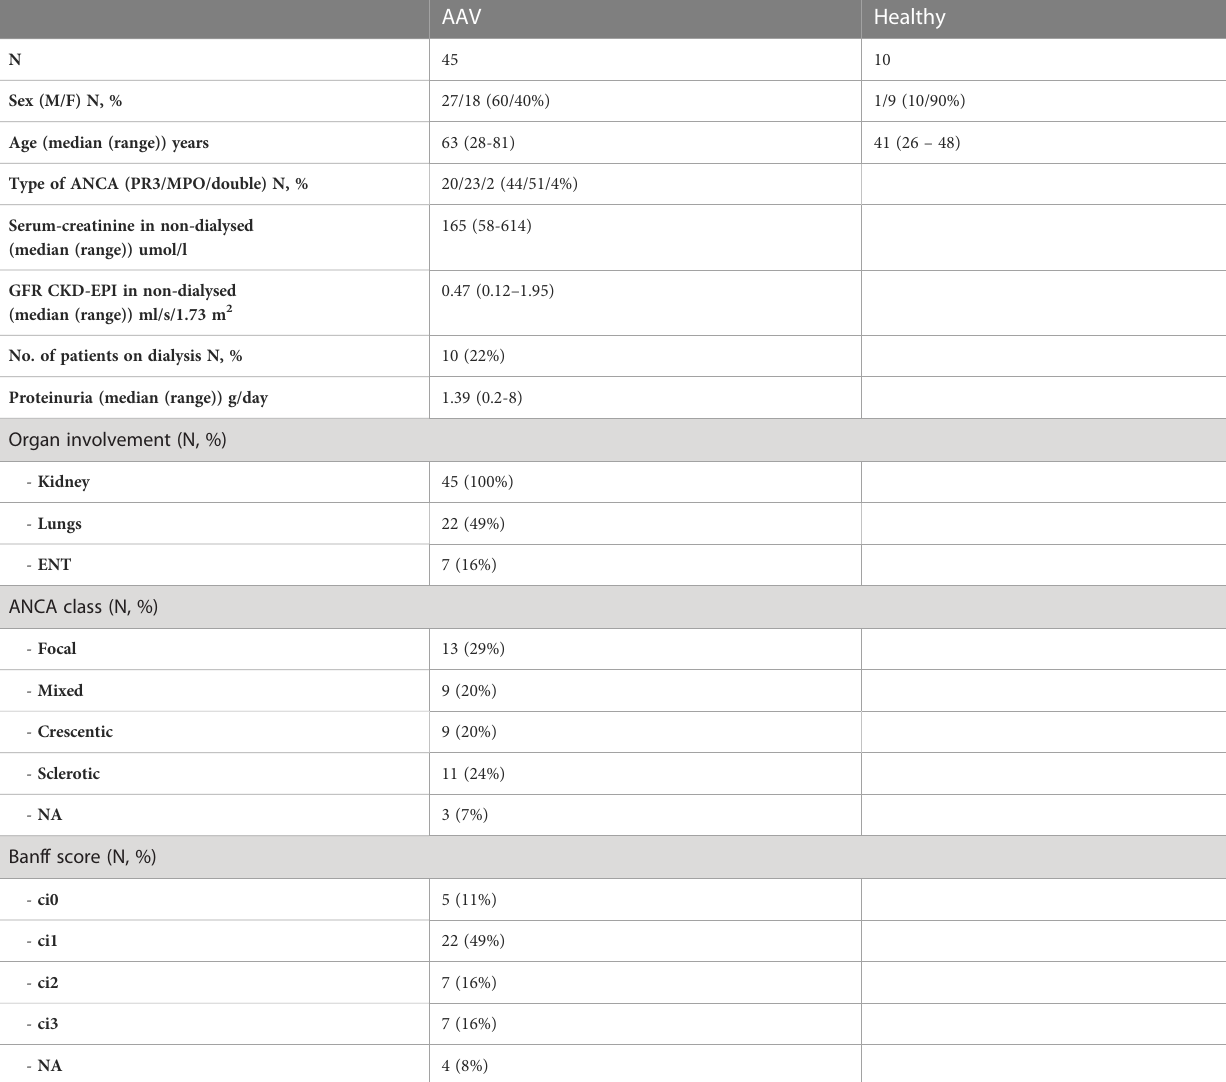
TABLE 1 Baseline characteristics of study subjects at